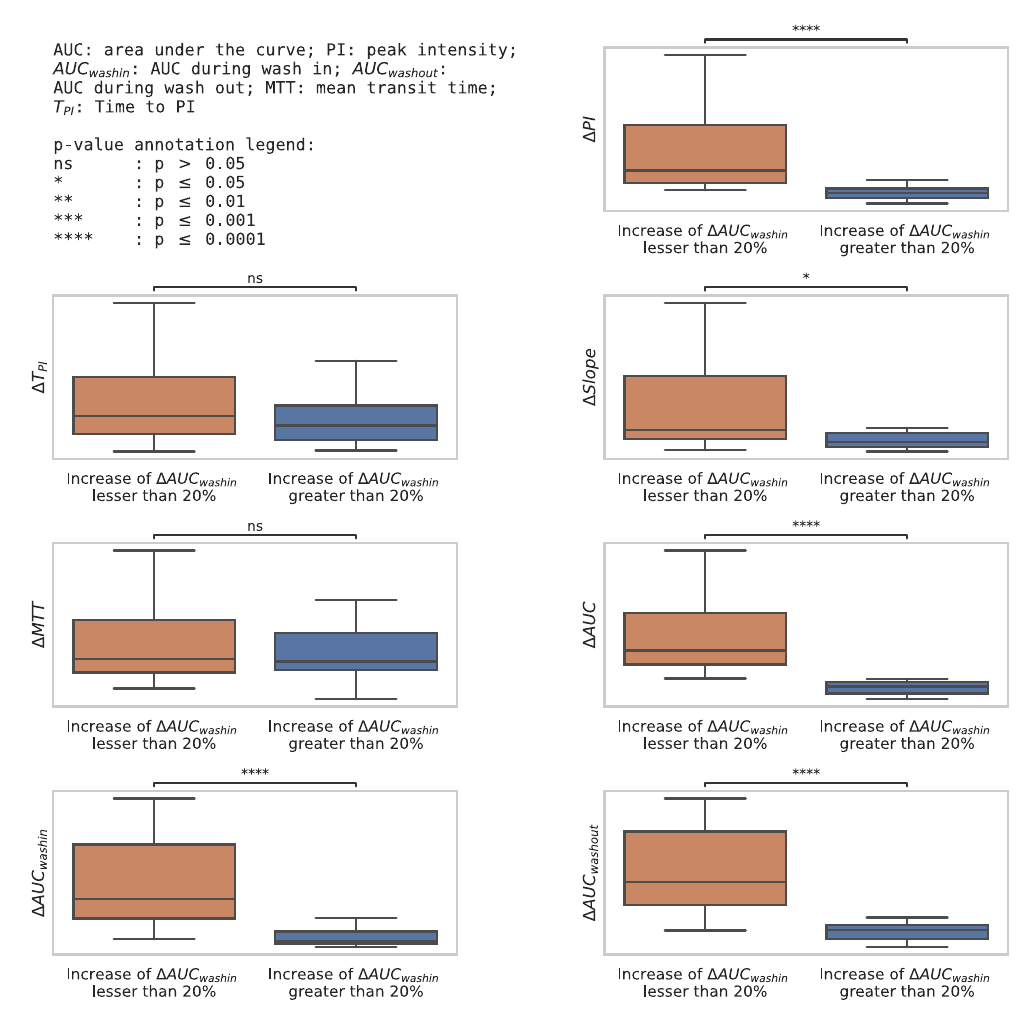
Figure 4. Box plot representing the change in perfusion parameters from baseline to D8 in the group of increase of ∆ AUC wash in greater than 20% (=12 patients) vs. in the group of increase of ∆ AUC wash in lesser than 20% (=25 patients).